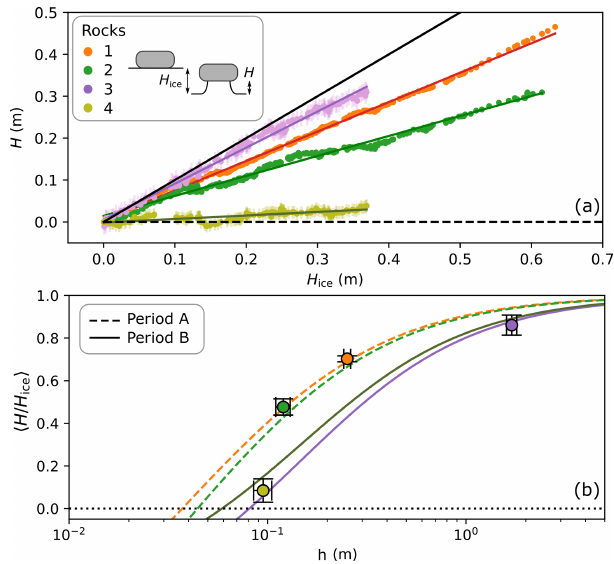
Figure 7. (a) Evolution of the height H of the ice foot under rocks 1–4 as a function of the ablated ice thickness H ice . The coloured lines correspond to linear adjustments of the data. The solid black line has a slope of 1. (b) The mean ratio of the height H of the ice foot under a rock and of the total ablated ice thickness H ice since the beginning of the table formation, as a function of the thickness h of the rock. The markers correspond to the slopes of (a) for each rock. The lines correspond to the application of the model for the meteorological values measured in period A (dashed lines) and B (solid lines) and the aspect ratio β of each rock given in Table